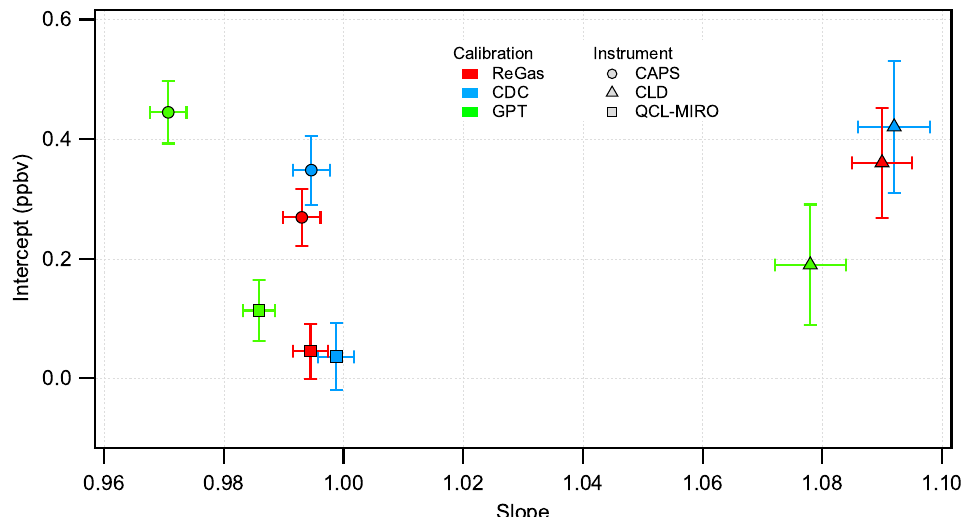
Figure 9. Intercepts and slopes of the linear regression of ambient air measurement data for the CLD, CAPS and QCL-MIRO vs. the QCL-Empa using three different calibration methods. The error bars represent the fit uncertainties (1 σ